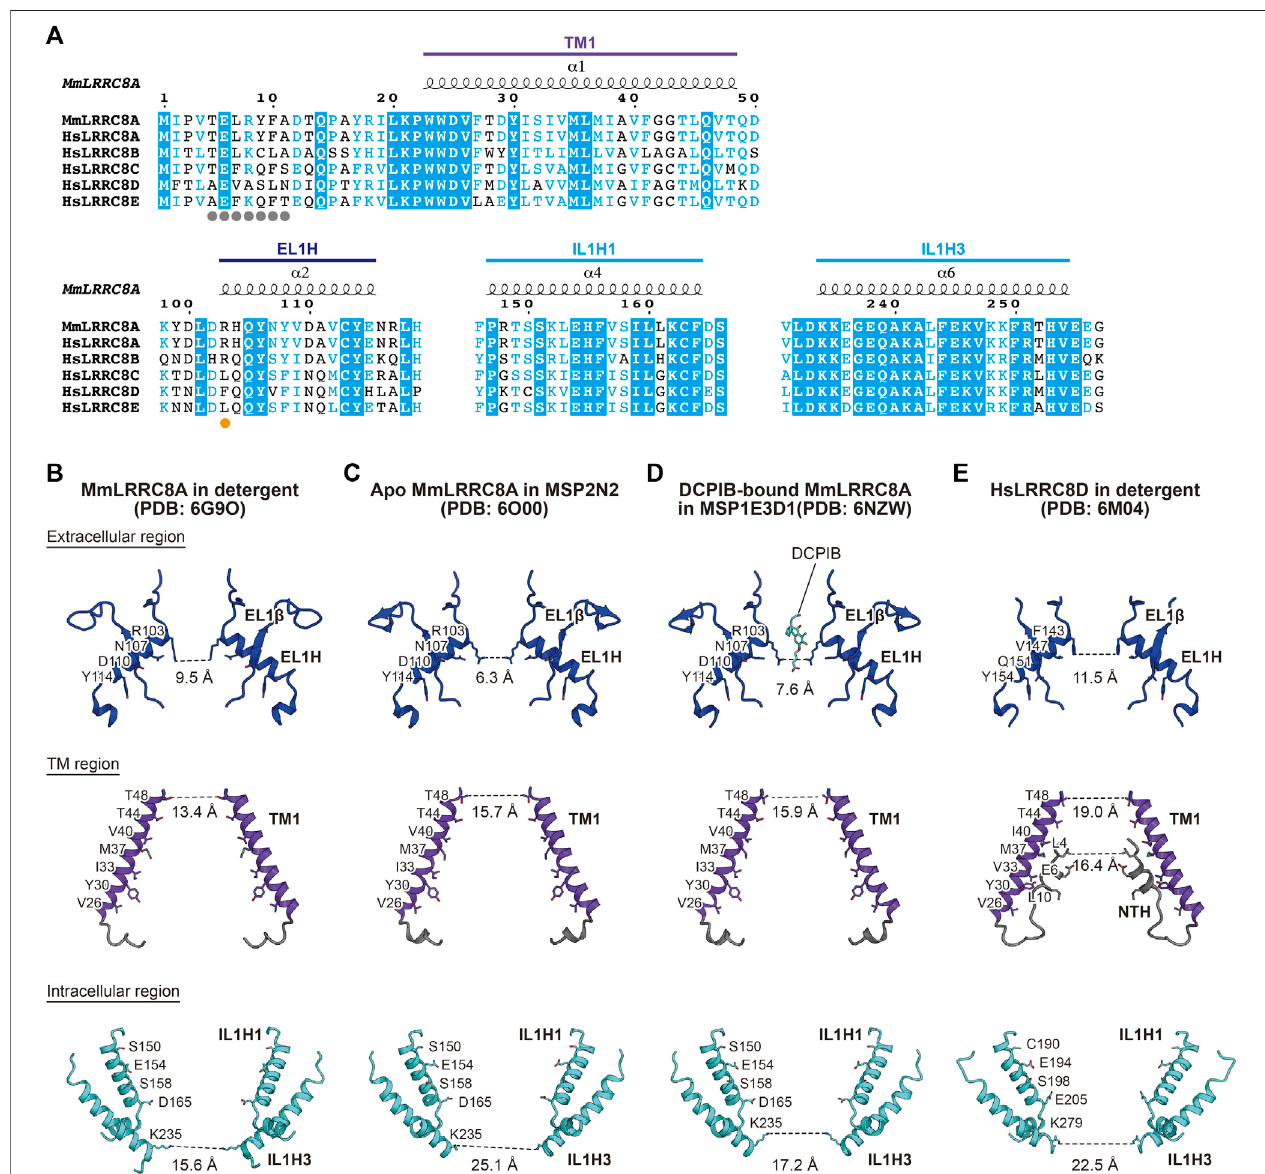
FIGURE 2 | Ion channel pore. (A) Sequence alignment around the ion channel pore ofLRRC8 isoforms. Amino acid sequences were aligned using Clustal Omega (Sievers et al., 2011) and are shown using ESPript3 (Robert and Gouet, 2014). The secondary structure elements and the colors of the domains from the MmLRRC8A hexamer in detergent (PDB: 6G9O) (Deneka et al., 2018) are labeled above the alignments. The amino acid residue involved in the pore constriction on the extracellular side is highlighted with an orange dot and those involved in the NTH formation in HsLRRC8D (Nakamura et al., 2020) are highlighted with gray dots. For the sequence alignment, the following LRRC8 isoforms were used: mouse (MmLRRC8A, NCBI Reference sequence number: NP_808,393.1) and human (HsLRRC8A, NP_062,540.2; HsLRRC8B, NP_056,165.1; HsLRRC8C, NP_115,646.3; HsLRRC8D, NP_060,573.2; HsLRRC8E, NP_079,337.2) (B – E) Close-up views of the channel pore-forming regions of MmLRRC8A in detergent (PDB: 6G9O) (Deneka et al., 2018) (B) , apo MmLRRC8A in MSP2N2 nanodiscs (PDB: 6O00) (Kern et al., 2019) (C) ,DCPIB-bound,constrictedMmLRRC8AinMSP1E3D1nanodiscs(PDB:6NZW)(Kernetal.,2019) (D) ,andHsLRRC8Dindetergent(PDB:6M04)(Nakamura et al.,2020) (E) .Only twodiagonal subunits viewed parallel to themembrane areshown forclarity.The side chains ofthepore-liningamino acidresiduesaredepicted in stick representations. The distances between the atoms in PDB coordinates involved in the pore constrictions are shown.